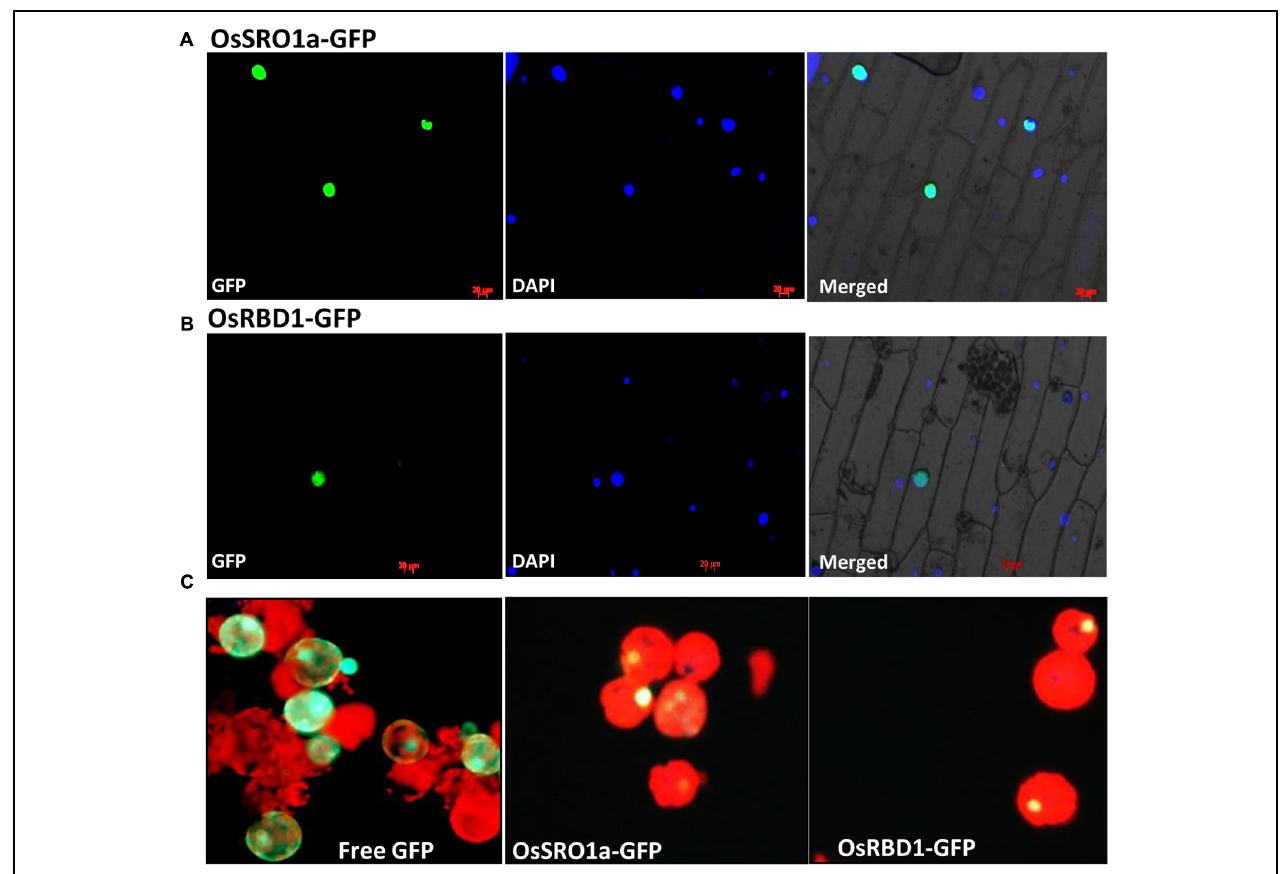
FIGURE 3 | In vivo localization of OsSRO1a and OsRBD1. Onion peel epidermal cells showing expression of (A) OsSRO1a-GFP and (B) OsRBD1-GFP driven by CaMV 35S promoter in the nucleus, as indicated by the superposition of GFP and DAPI dye fluorescence. (C) Tobacco leaf protoplasts transfected with pMBPII vector alone (for free GFP visualization; left panel) and, OsSRO1a-pMBPII (middle panel) and OsRBD1-pMBPII (right panel) to confirm the nuclear localization of OsSRO1a and OsRBD1, respectively.